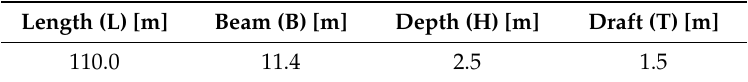
Table 1. Basic ship dimensions.